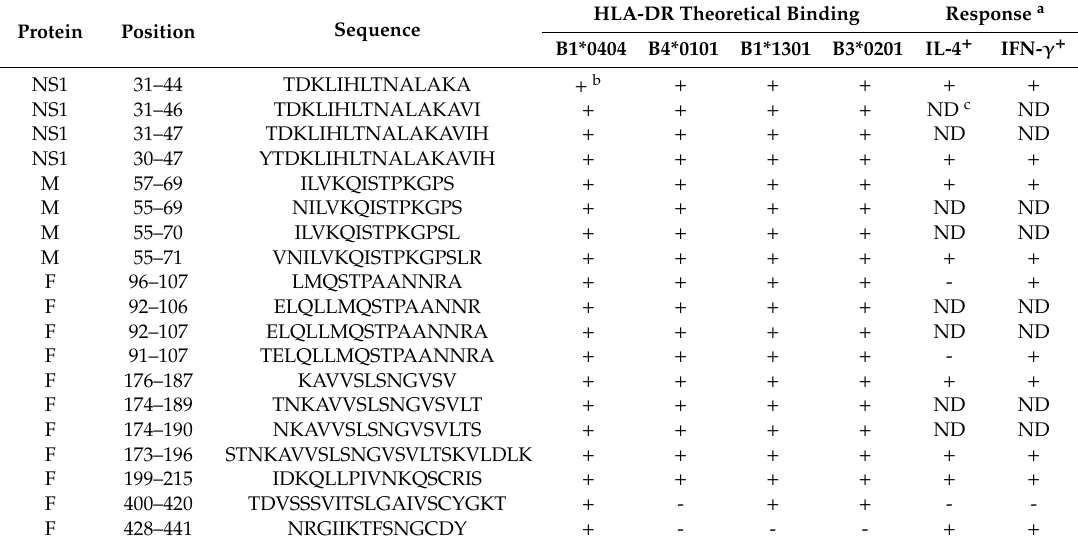
Table 3. Summary of the viral HLA-DR natural ligands identified by immunoproteomics analyses in HRSV-infected cells. Protein Position